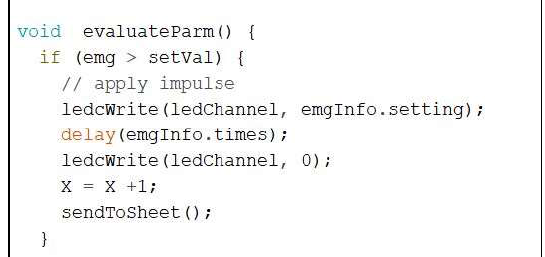
Figure 8. Code 7 — stimulation pulse .